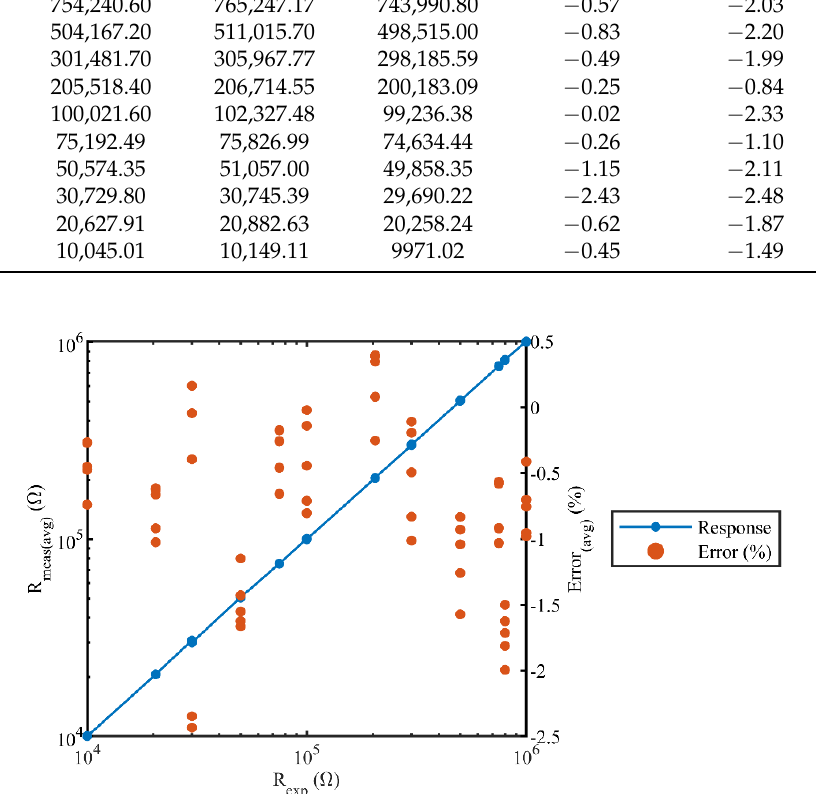
Figure 8. System response depicting the expected versus measured resistances and the average errors.